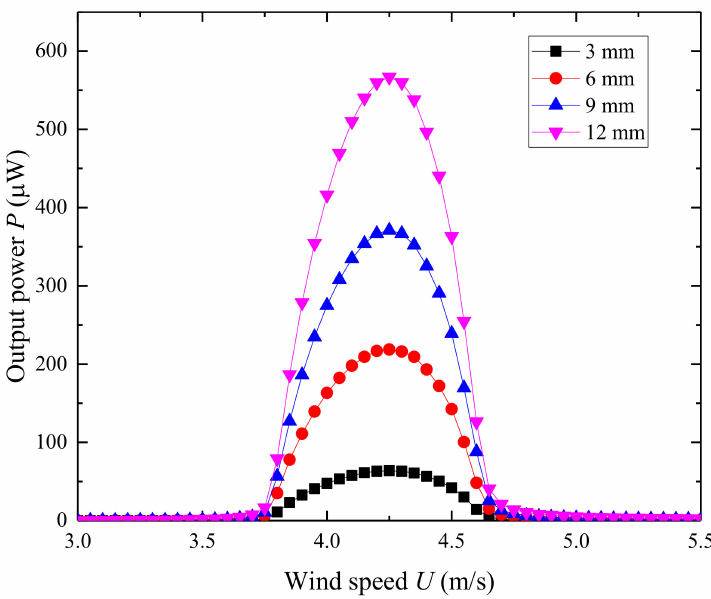
Figure 14. Variation of the output power P as a function of the width of piezoelectric